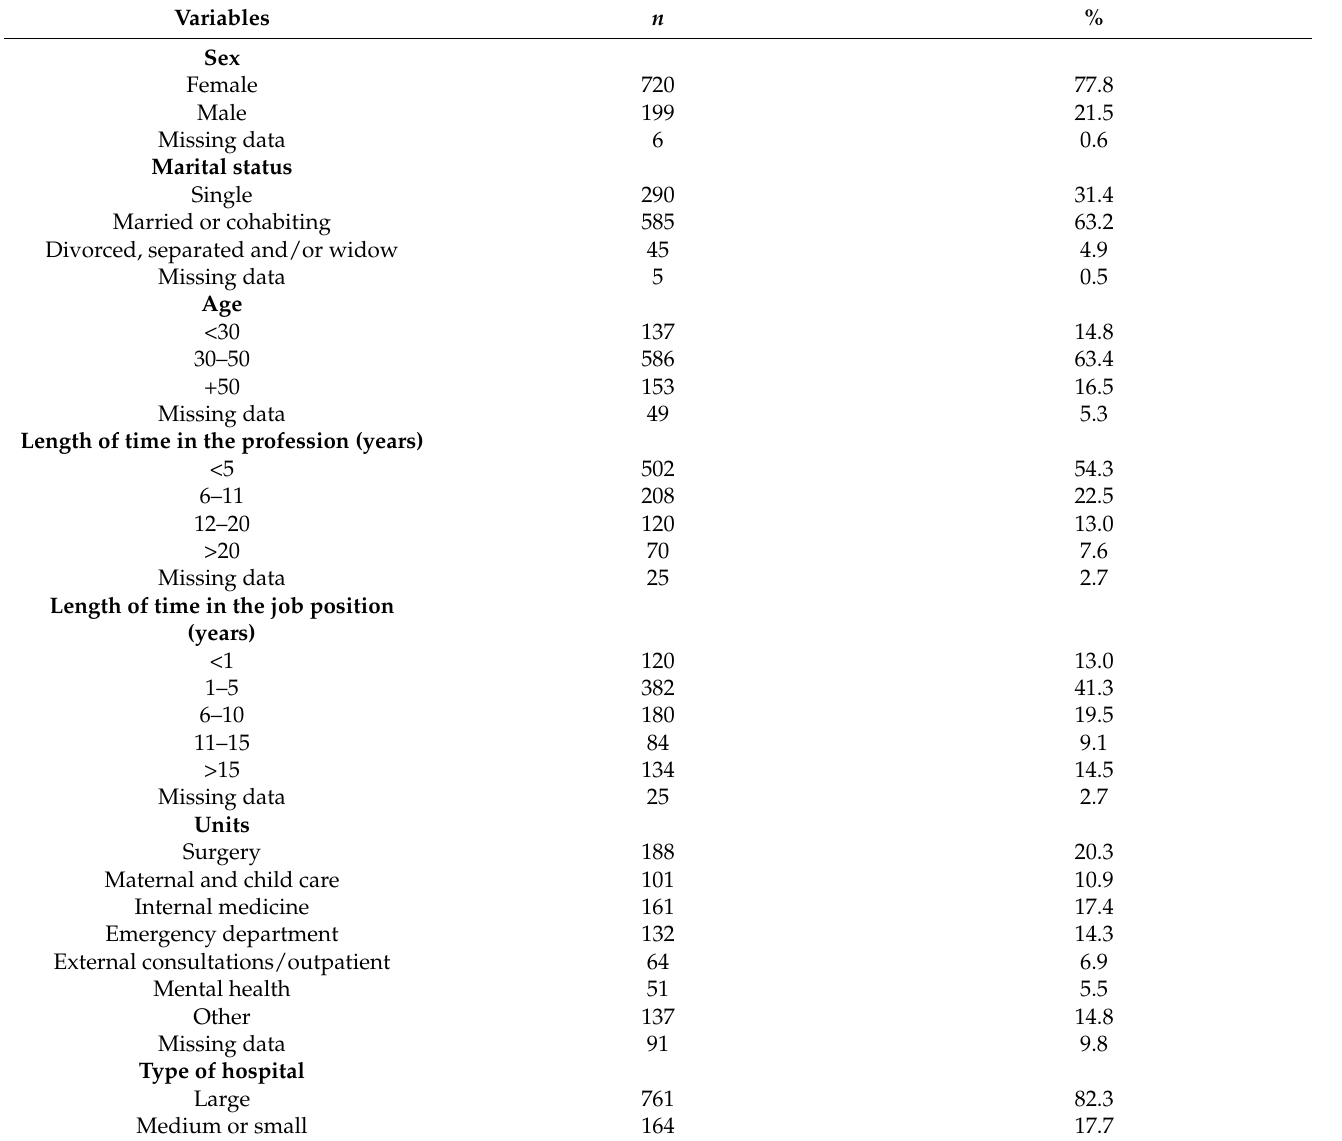
Table 1. Sociodemographic and work-related